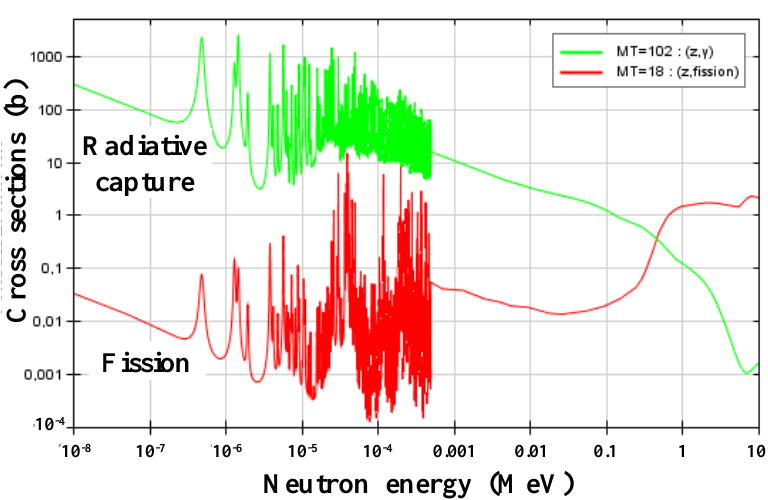
Figure 3. 237 Np micro cross-sections of radiative neutron capture and fission reactions.